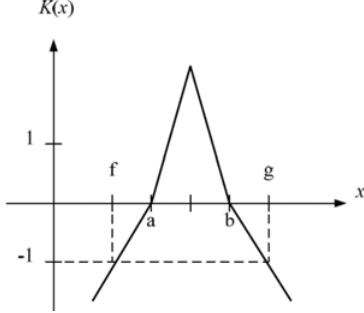
Figure 7. Extension membership function.